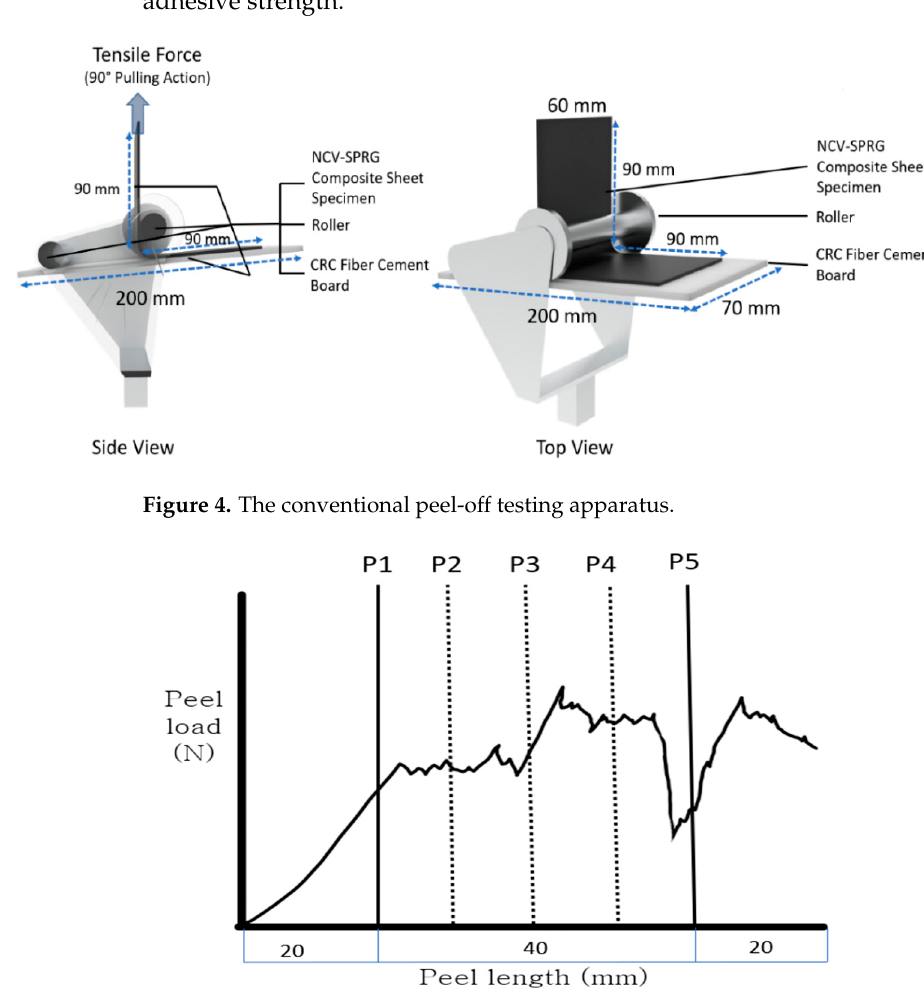
Figure 5. The conventional peel-off testing data.